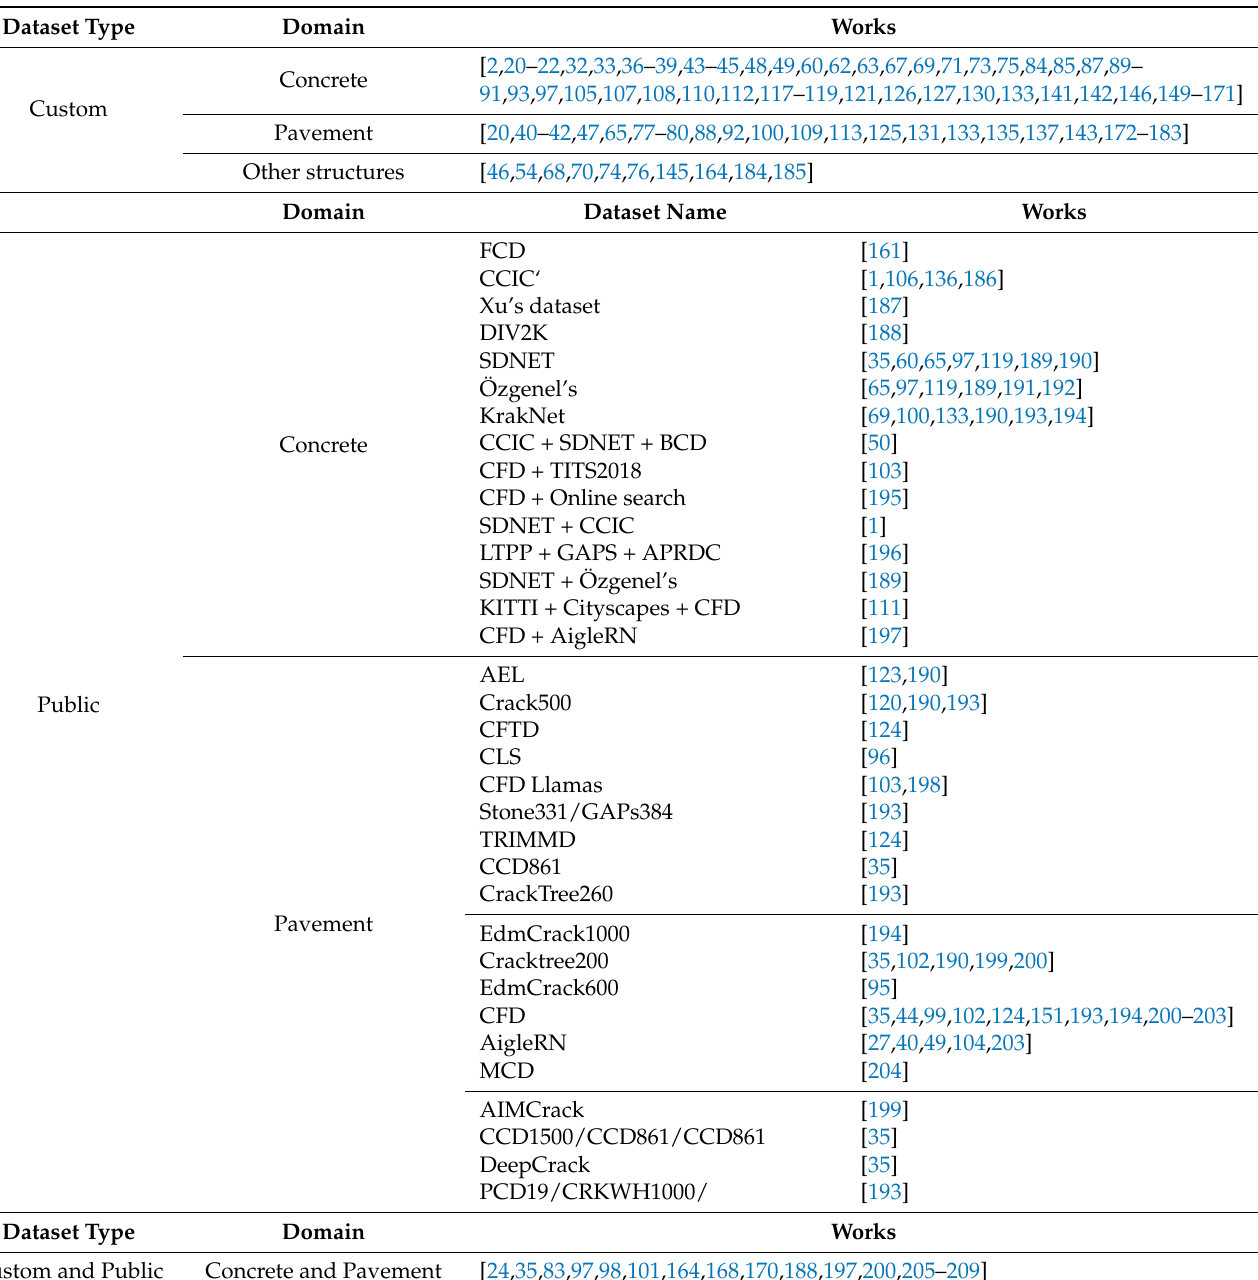
Table 10. Image datasets on crack